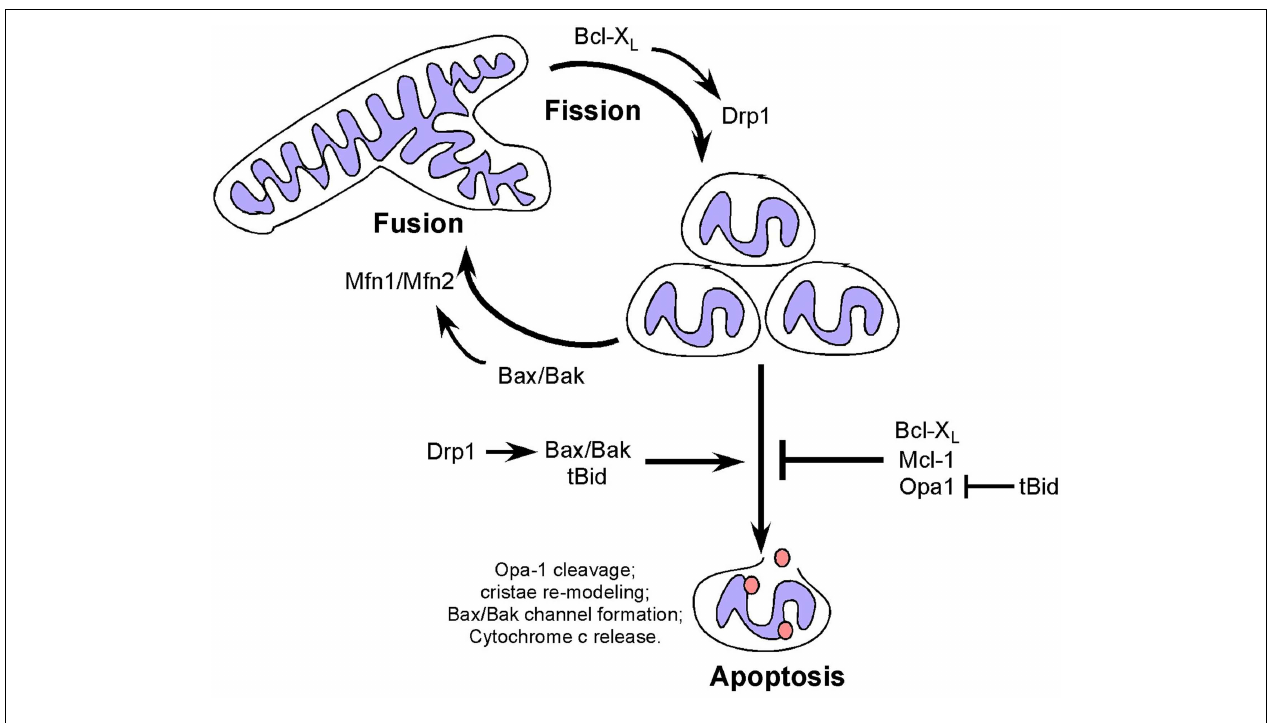
their roles in mitochondrial dynamics but which involve members of the Bcl-2 family. Conversely, Bcl-2 family members modulate mitochondrial fission and fusion in a manner that appears to be independent of their functions in